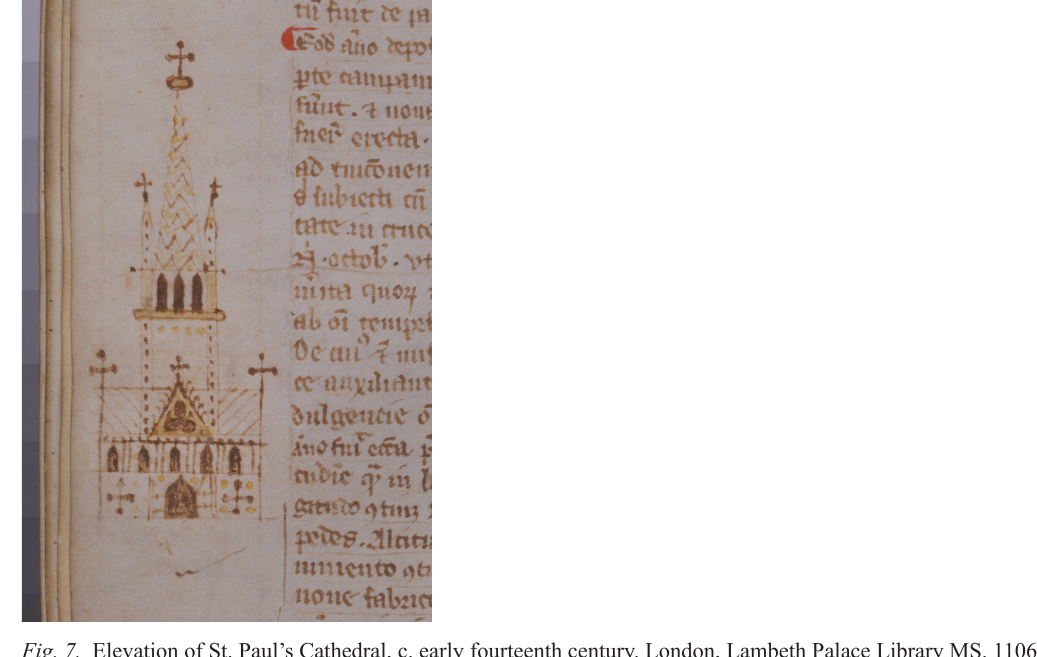
Fig. 7. Elevation of St. Paul’s Cathedral, c. early fourteenth century. London, Lambeth Palace Library MS. 1106, f. 96v. By permission of Lambeth Palace